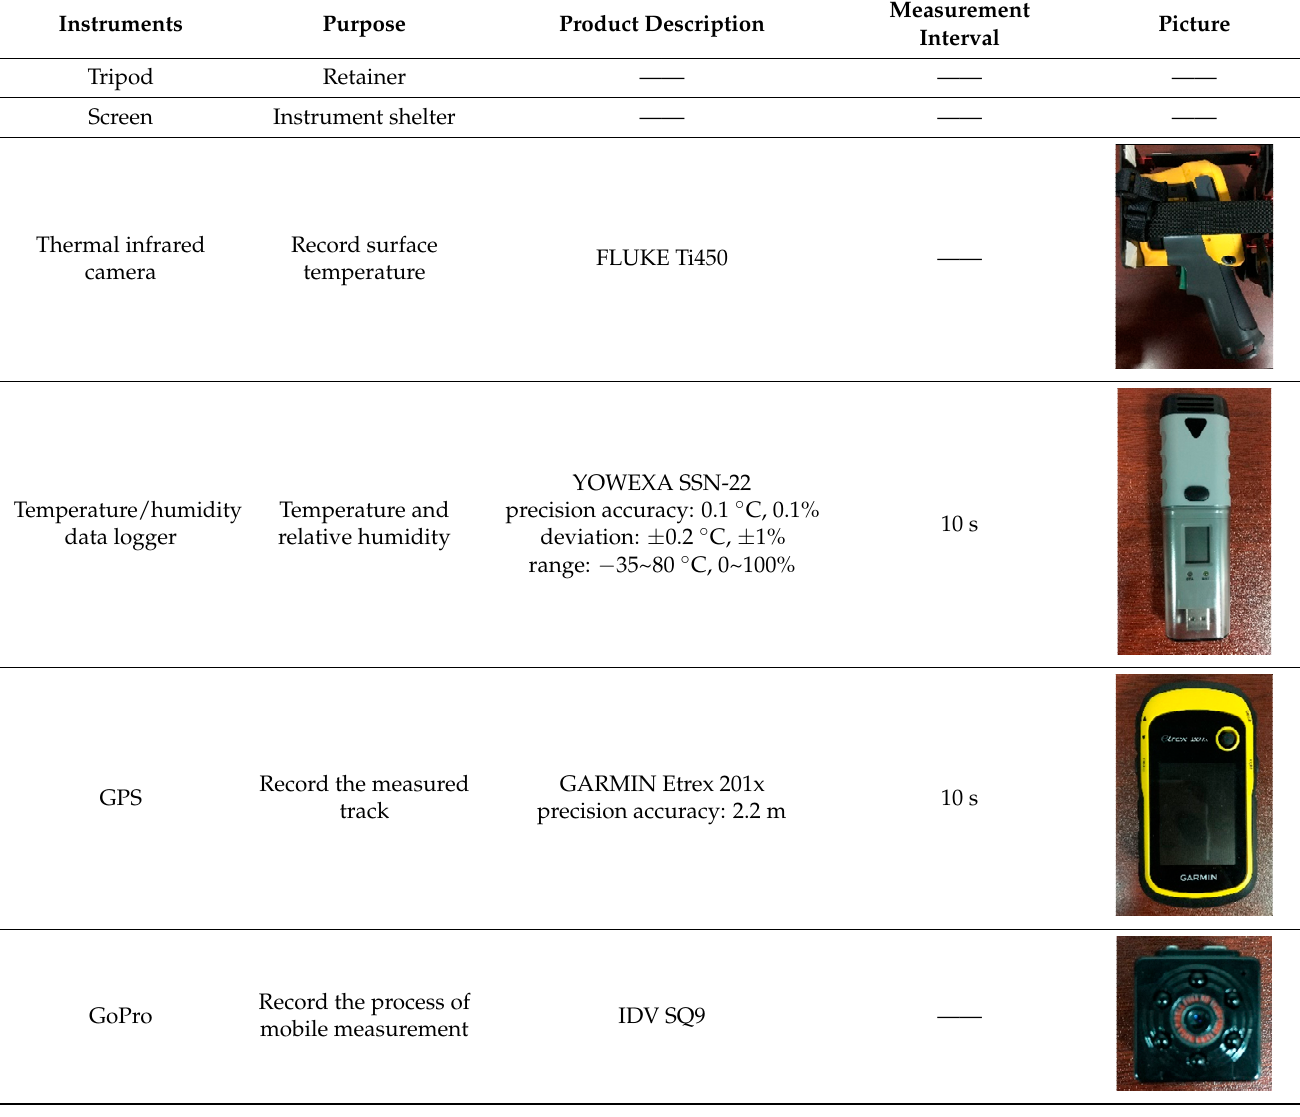
Table 4. Details of the measurement instruments.